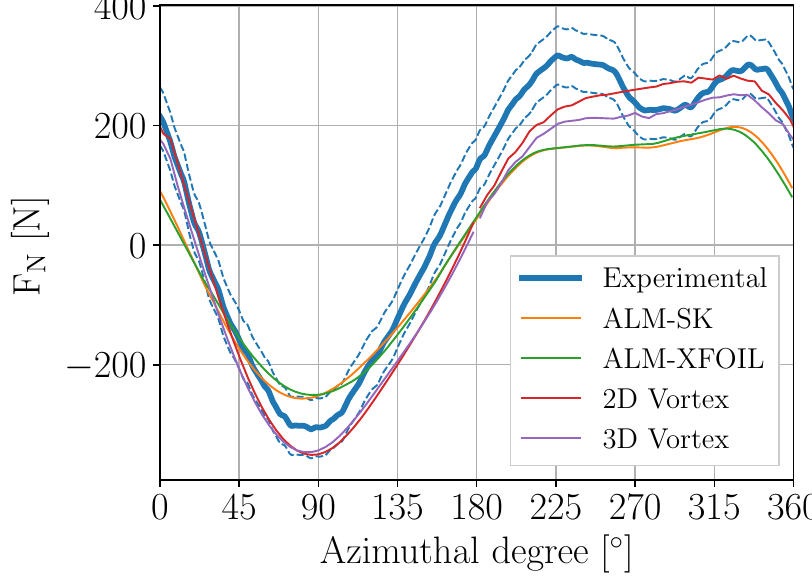
Figure 11. The normal force response at λ =